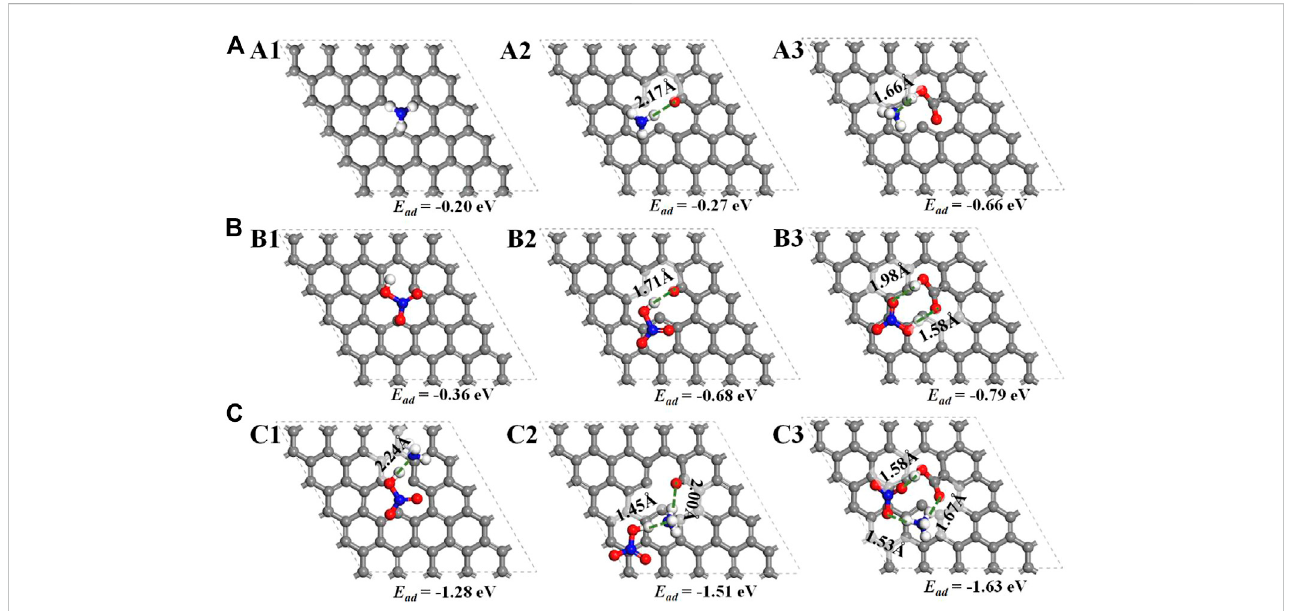
FIGURE 9 Geometrically optimized con fi gurations ofadsorbedNH 3 (A1 – A3) ,adsorbedHNO 3 (B1 – B3) and co-adsorbed NH 3 /HNO 3 (C1 – C3) on defected carbon, defected carbon with carbonyl and defected carbon with carboxyl from the top view with their adsorption energy and hydrogen-bond length labeled, respectively. (Only the top layer is displayed. Atomic legend: -C , -H , -O ,